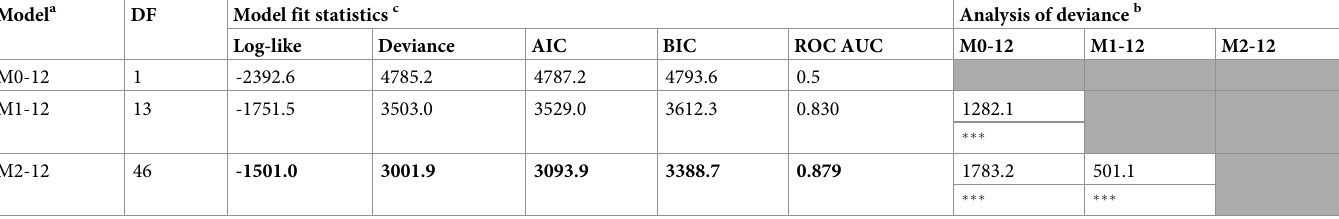
Table 4. Comparison between logistic regression models of different complexity and structure derived from the 12 covariates chosen using subjective feature selection. Model a DF Model fit statistics